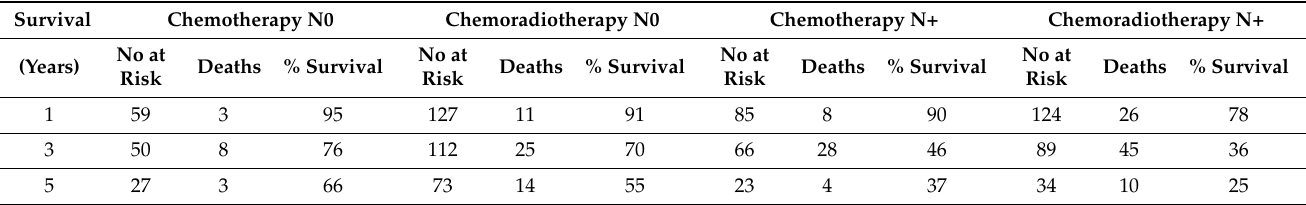
Table 5. Overall survival of OAC patients based on nodal status and treatment received